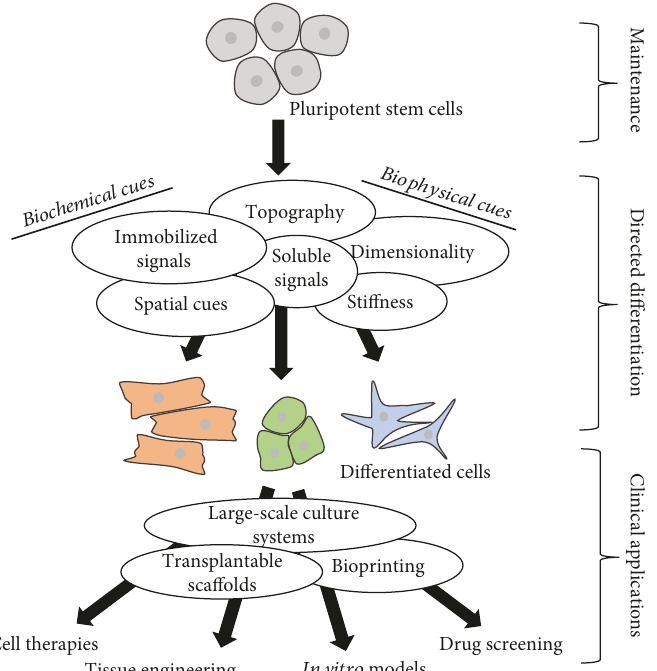
Figure 5: Summary of PSC technology, methods for directing di ff erentiation, and potential avenues for biomaterial contribution to translation into regenerative medicine and personalized